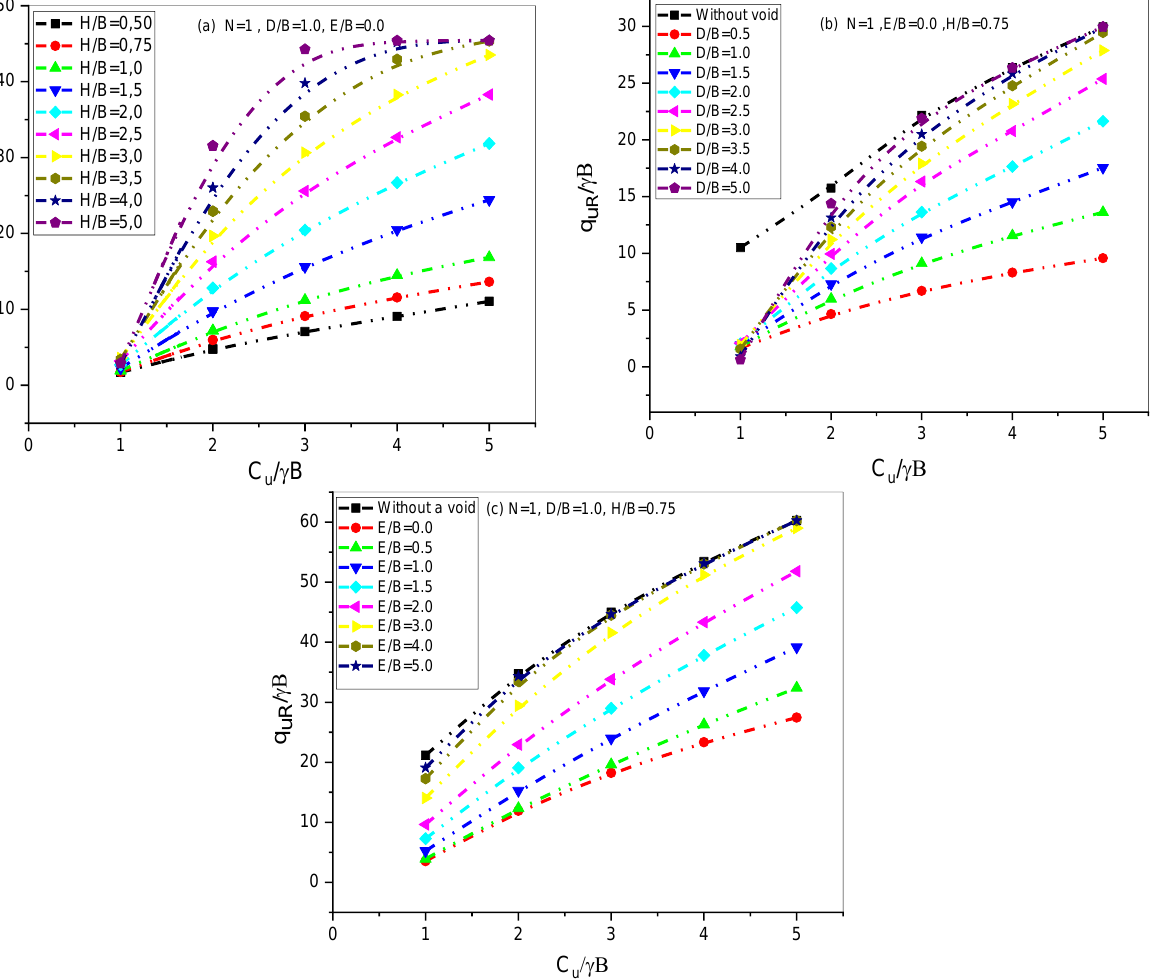
Figure 13. Effect of reinforcement on the ultimate bearing capacity ratio qu/γB for different Cu/γB parameters with the existence of one void.